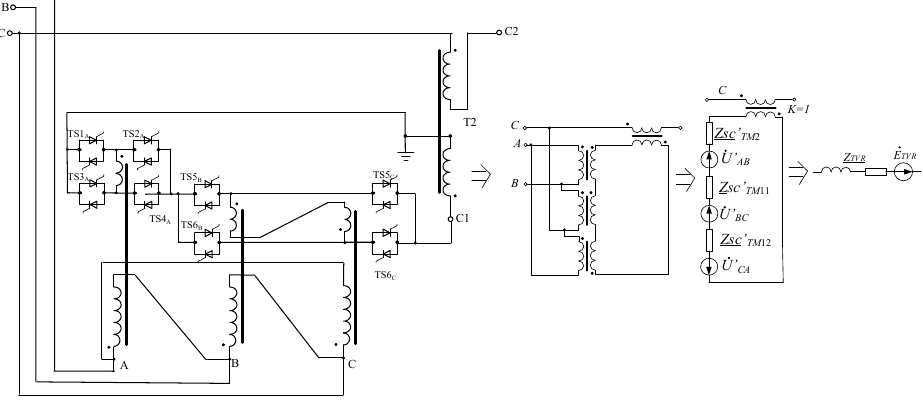
Figure 8. The equivalent circuit of the TVR phase.